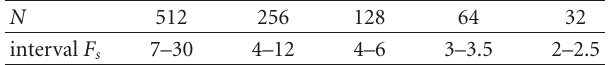
for small errors when opt